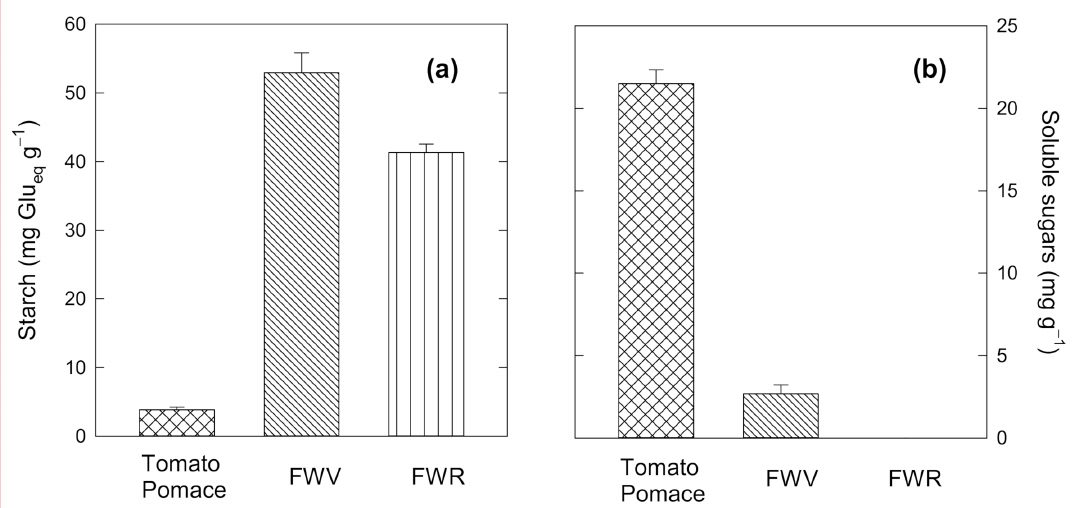
Figure 3. Starch ( a ) and Soluble sugars ( b ) for the two FW substrates and Tomato Pomace as reference